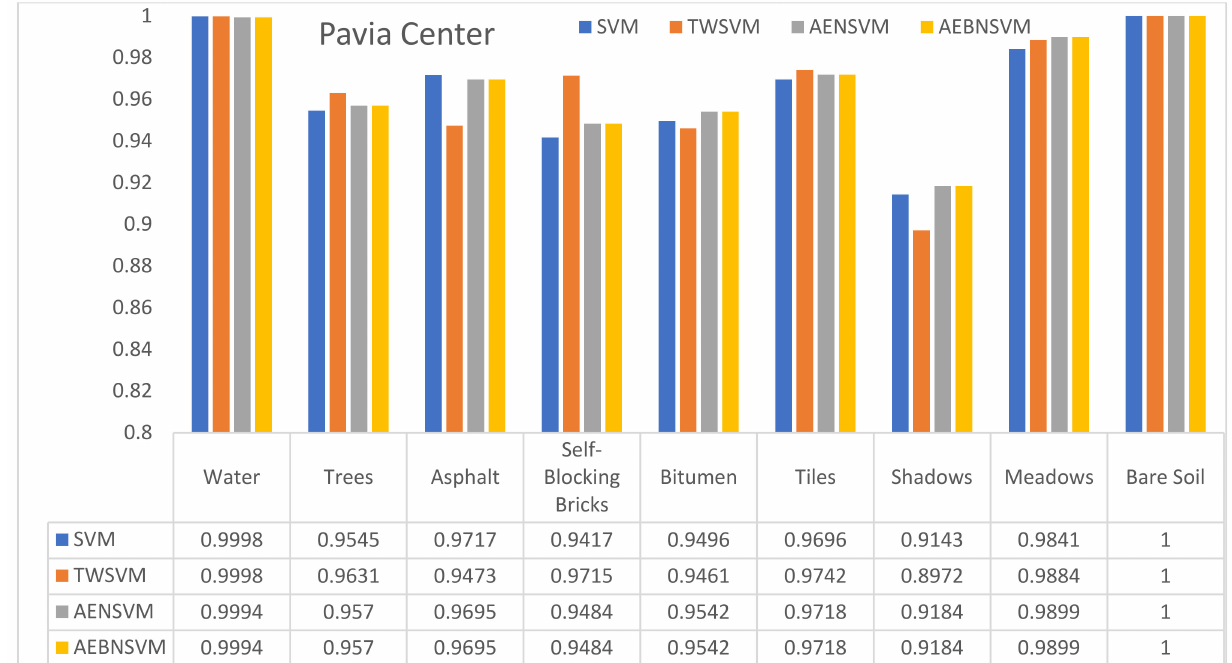
Figure 8. Classification results of different categories of Pavia Center hyperspectral